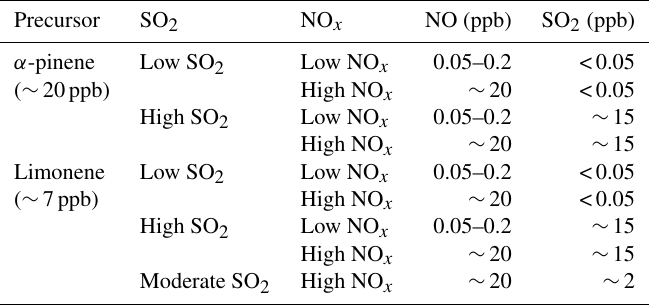
Table 1. Overview of the experiments in this